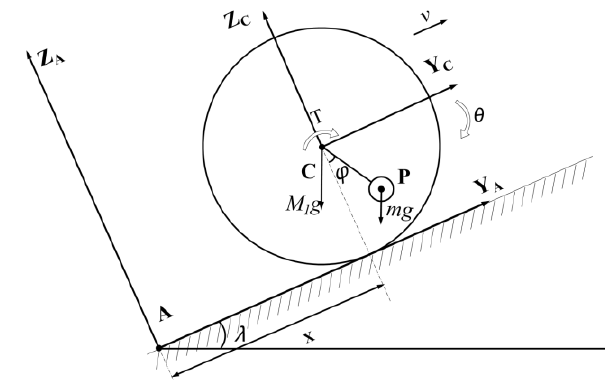
Figure 13. Schematic diagram of climbing.